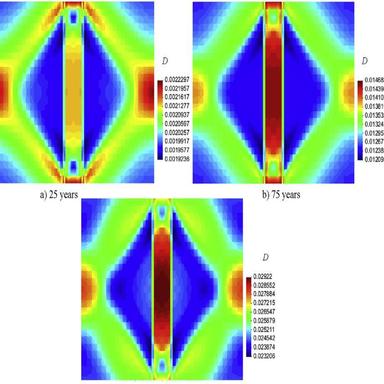
Damage variable D distribution with time.